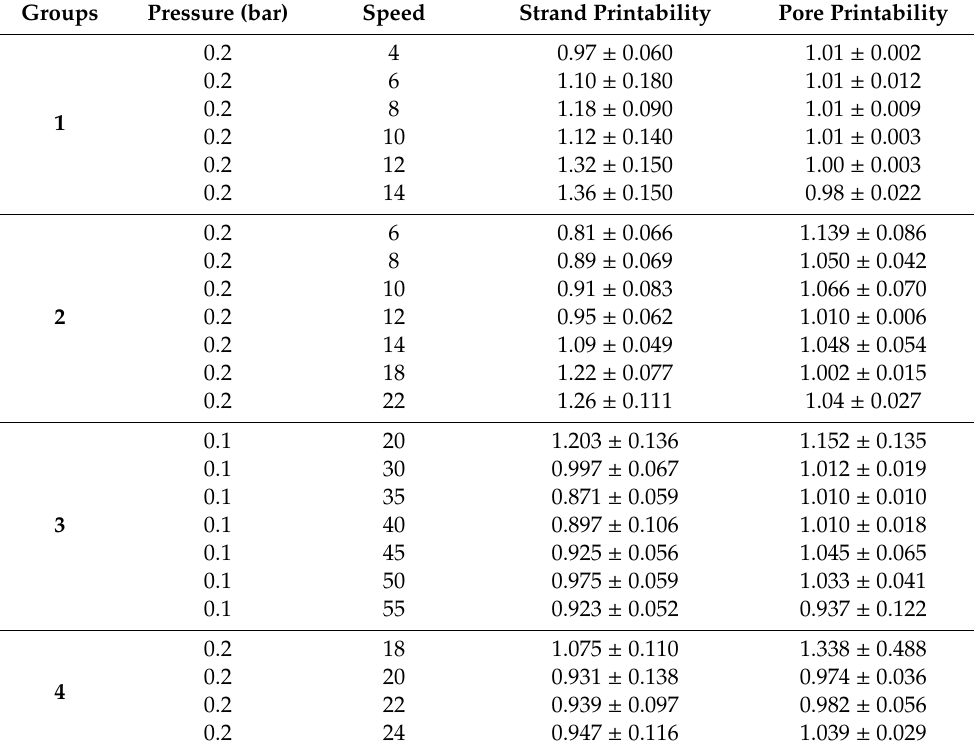
Table 2. E ff ect of nozzle speed on strand and pore printability.